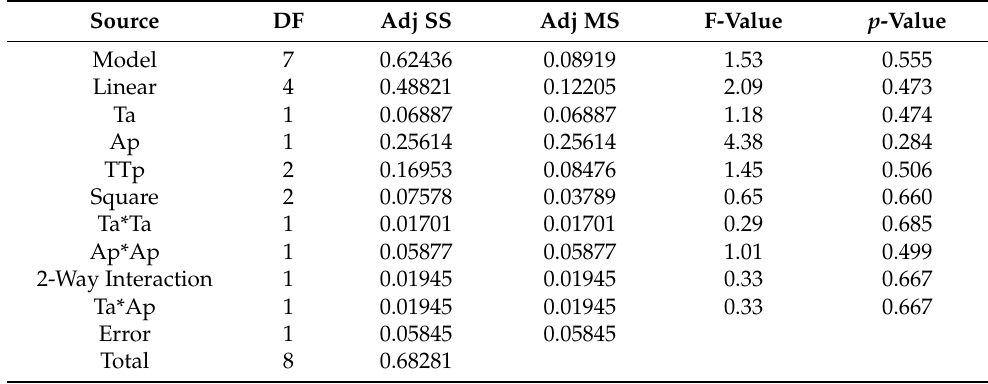
Table 6. Analysis of Variance